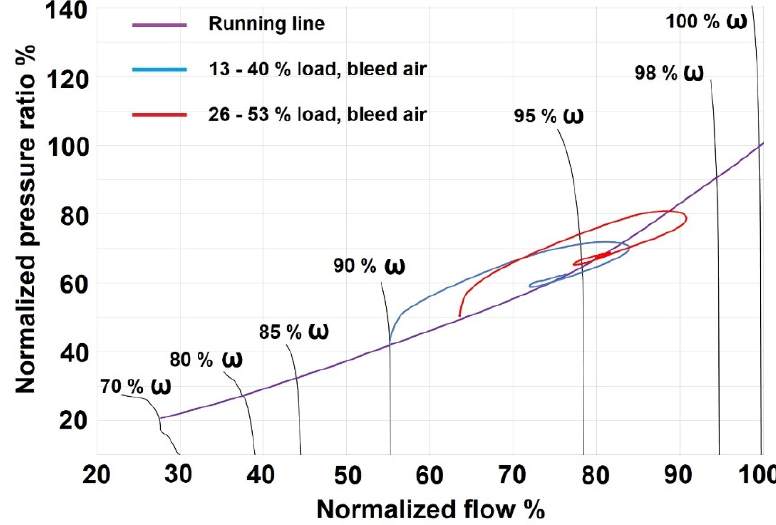
Figure 12. Representation of transient compressor response on compressor performance map for 13–40% load and 26–53% load with bleed air.